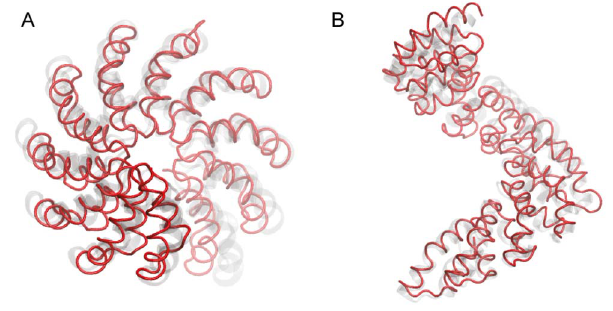
Figure 4. Comparison of dHax3 TALE structures. An in silico structure (shown as red tube) obtained from force-induced stretching of the dHax3-DNA conformation is superimposed with the DNA-free crystal structure of dHax3 (shown as transparent grey ribbons). Top view (A) and side view (B) perspective is shown.